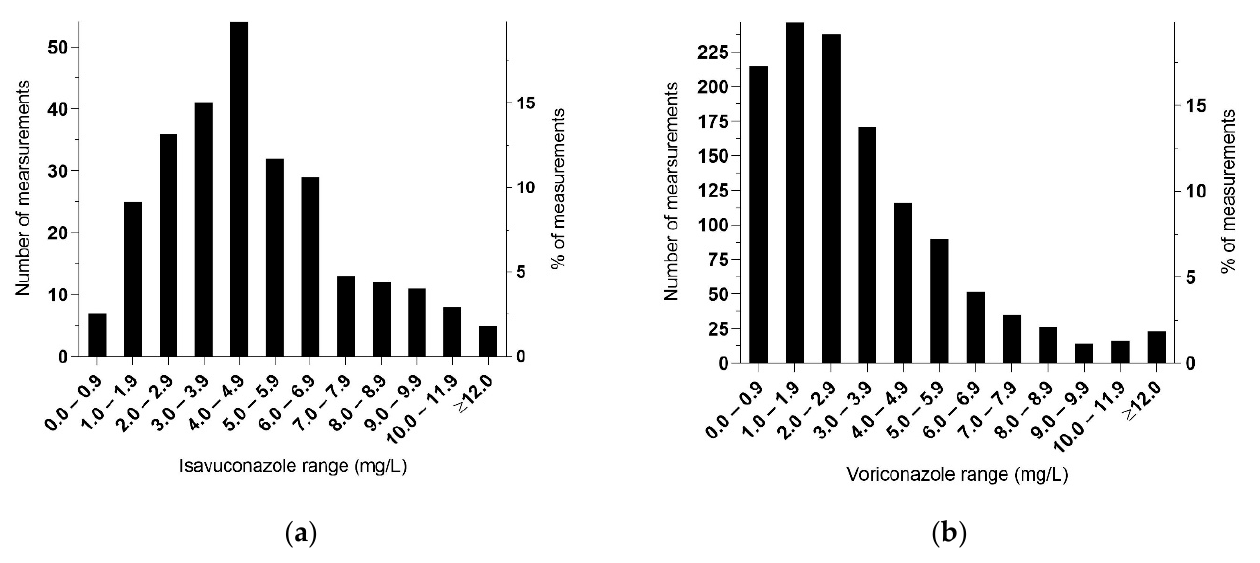
Figure 1. Distribution range of serum concentrations. ( a ) 273 s-ISZ concentrations measured from 35 patients at SSI. Patients received various dosages and the plots do not describe exposures after administration of standard dosing. ( b ) 1242 s-VRZ concentrations measured from 283 patients.